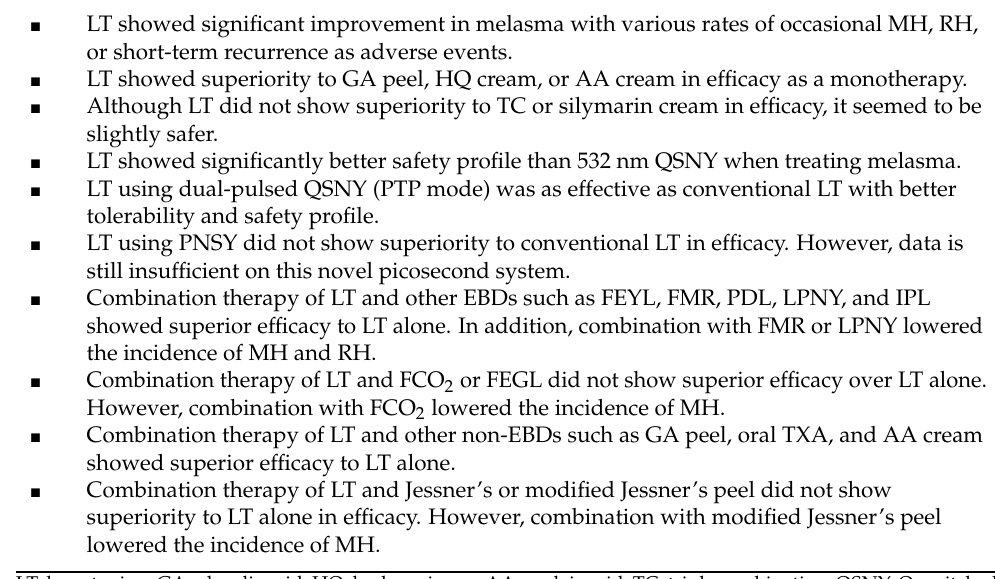
Table 3. Summary of highlighted outcomes in this